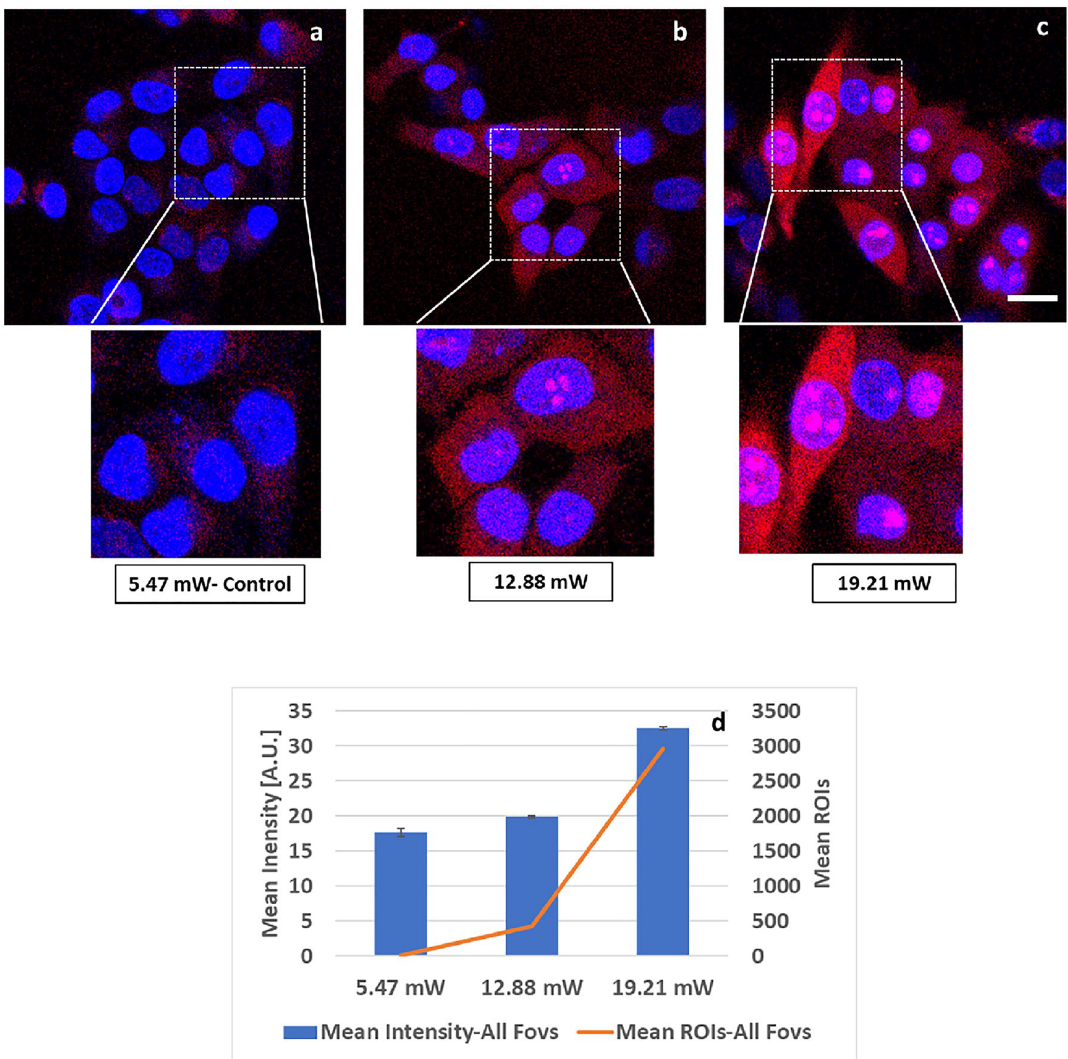
Figure 6. Increase in mitochondrial oxidative stress at increasing 2p-laser power excitation in HeLa cells. Representative confocal images of MitoSOX (mitochondrial ROS/superoxide) signal imaged under identical conditions with 514 nm at 10% (Em-551–683 nm, PMT 750v), after FLIM acquisition with 740 nm. All images were contrasted for brightness at the same settings to show the expected low-level ROS signal in cancer cells in the control image. Confocal MitoSOX signal after FLIM at laser average power of ( a ) 5.47 mW-Control and after increased FLIM laser power of ( b ) 12.88 mW and ( c ) 19.21 mW. The rising MitoSOX signal is indicative of oxidative stress not apparent in control ( a ). Hoechst nuclear stain was applied for nuclear localization. ( d ) Mean intensity (± SEM) bar plots and mean ROIs counts (2 × 2 pixel, orange line) from 4 FOVs show increase in MitoSOX Red mean gray-level intensity (8-bit depth) from 17.64 to 19.87 (12.6% increase) to 32.52 (84.3% increase); and mean ROI counts (orange line) from 10 to 427 (~ 40-fold increase) to 2964.75 (~ 300 fold increase) in ROI counts post FLIM with 5.47 mW-Control, 12.88 mW and 19.21 mW respectively-indicating increase in oxidative stress signal with higher laser average power. Single factor Anova analysis was done for mean intensity for statistical significance between groups at alpha value of 0.05. The results were statistically significant with p value of < 0.0001 . Scale bar 20